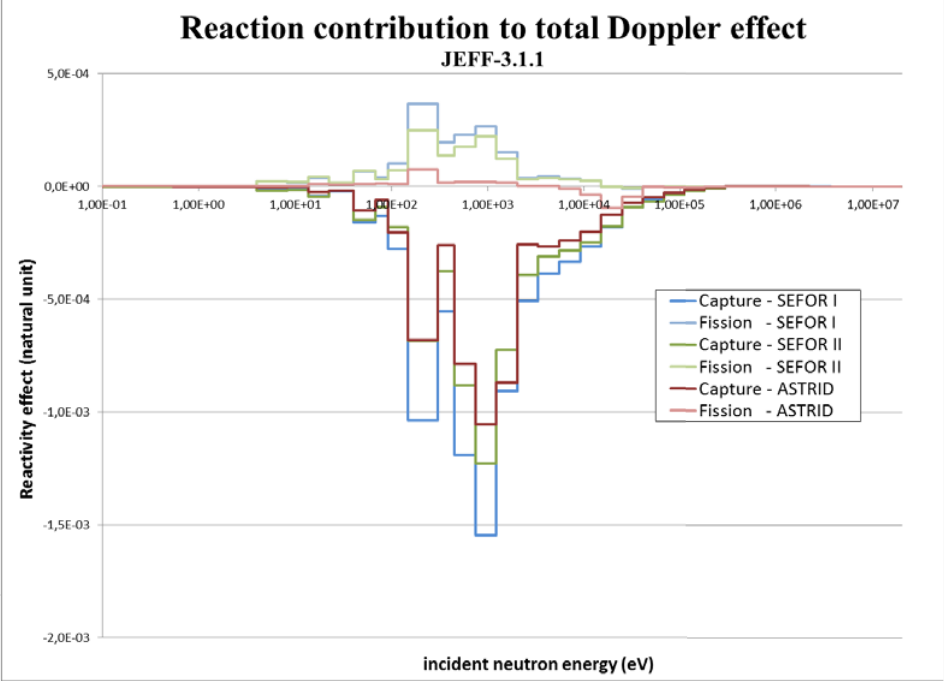
Figure 3. Doppler Effect breakdown in reactivity for SEFOR cores I & II and ASTRID core SEFOR cores I & II display compensations between total capture and fission reactions while this effect is practically nonexistent for ASTRID: in a softer spectrum, fission cross sections broadening of nuclides with fission thresholds doesn’t affect the reactivity as